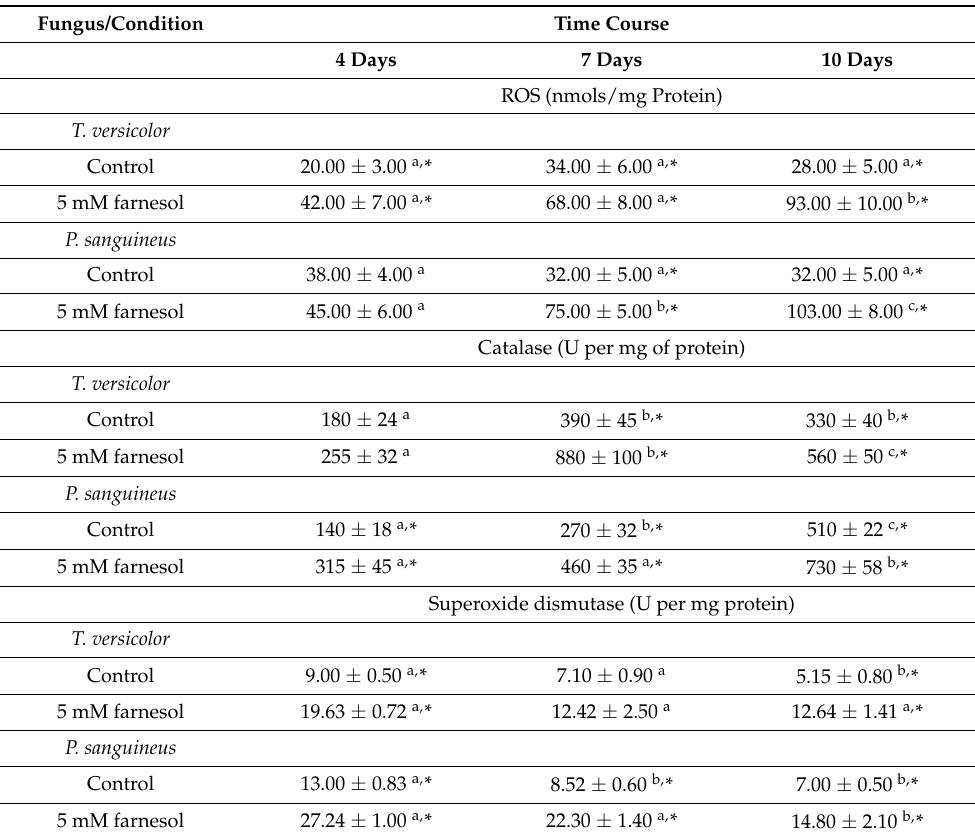
Table 2. Effect of farnesol concentration on the production of ROS, catalase, and superoxide dismutase by T. versicolor and P. sanguineus in